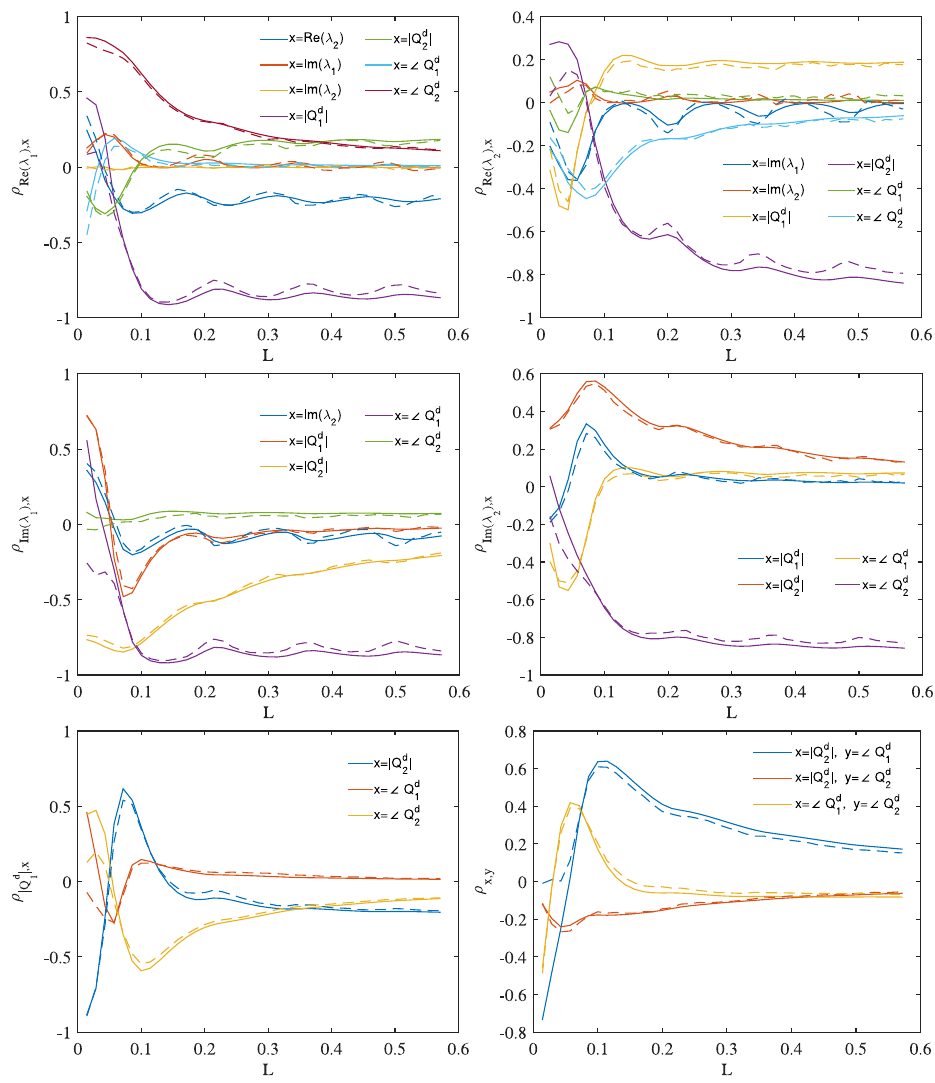
Figure 2. Noise linear addition approximation for the pulse with (cid:31) 1,2 = ( 6 j , 5 j ) and Q d 1,2 = ( − 6 j , − 2 j ) . Solid curves: model predictions, dashed curves: pulse propagation